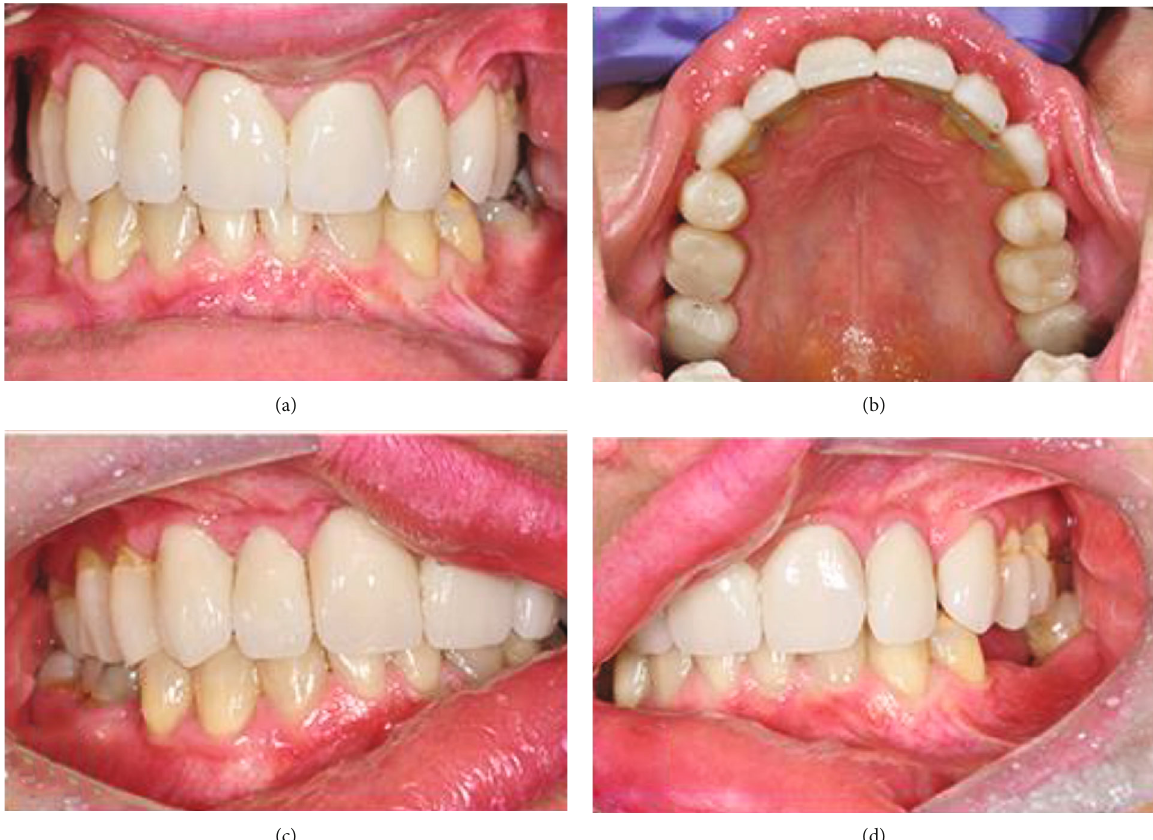
Figure 6: A 29-year-old patient with CCD. (a) Intraoral view of fi nal restoration. It was patient ’ s strong wish for restorations to be this bright, even though it did not match her natural teeth. (b) Intraoral occlusal view of maxillary arch after accomplished prosthodontic treatment. (c) Lateral view of the right side after 24 months follow-up. (d) Lateral view of the left side after 24 months follow-up.